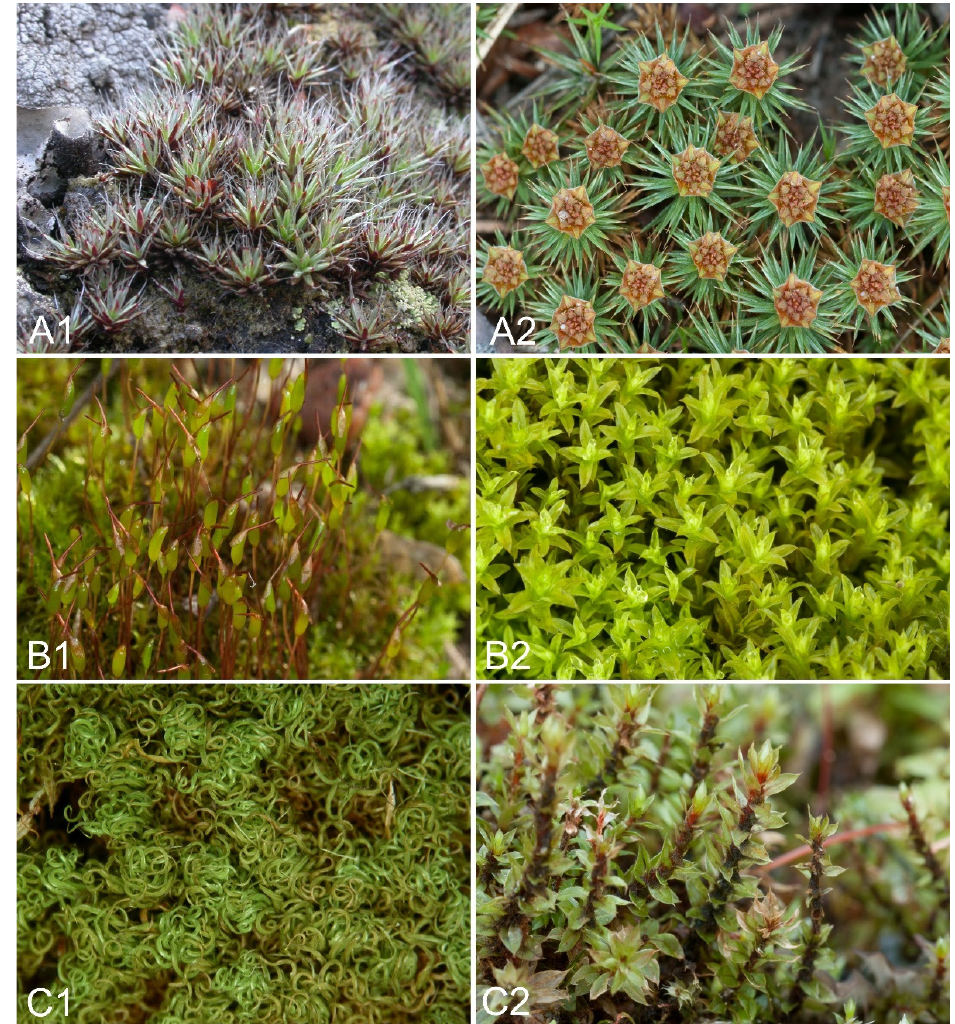
Figure 6. Examples of bryophyte species representing the three defined groups ( A – C ) according to their sensitivity to heavy metal pollution. ( Group A ): ( A1 )— Polytrichum piliferum , ( A2 )— Polytrichum juniperinum ; ( Group B ): ( B1 )— Ceratodon purpureus , ( B2 )— Barbula unguiculata ; ( Group C ): ( C1 )— Tortella tortuosa , ( C2 )— Bryum pseudotriquetrum .